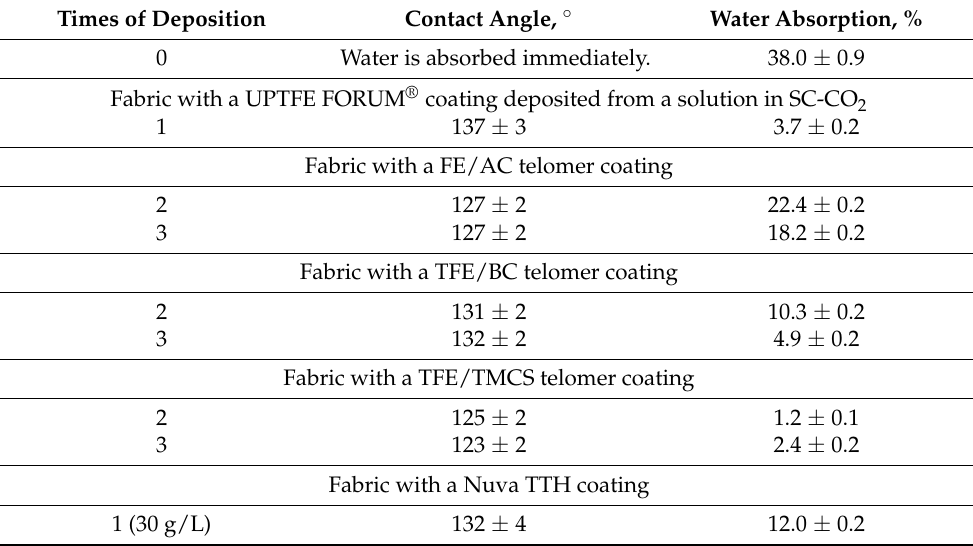
Table 2. Hydrophobicity resistance to different types of wear.